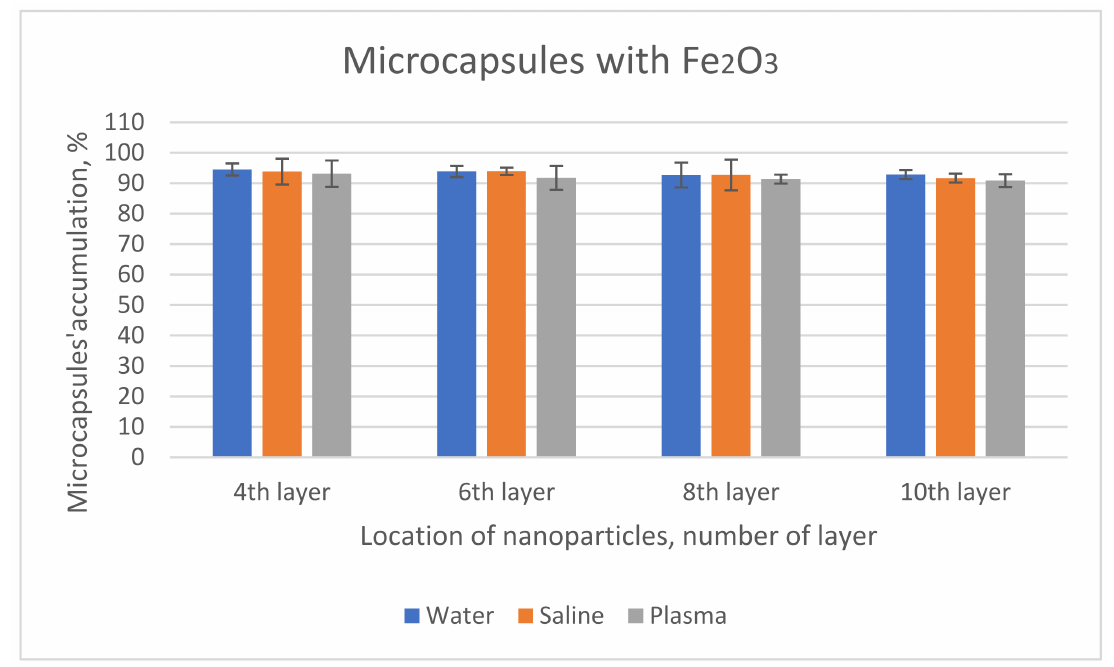
Figure 4. Accumulation of microcapsules containing Fe 2 O 3 nanoparticles,